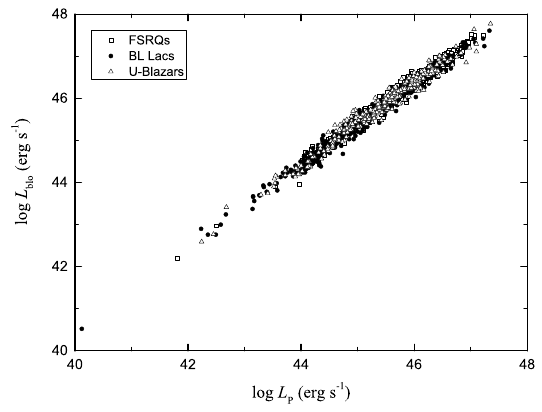
Figure 5. The correlations between bolometric luminosity (log L bol ) and peak luminosity (log L p